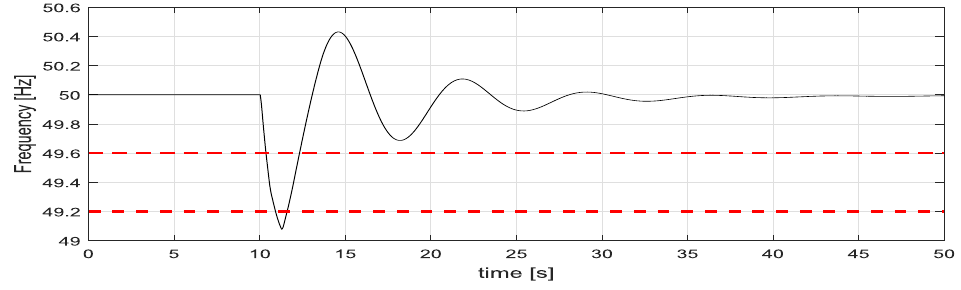
Figure 10. Time evolution of frequency on the busbar at 33 kV.